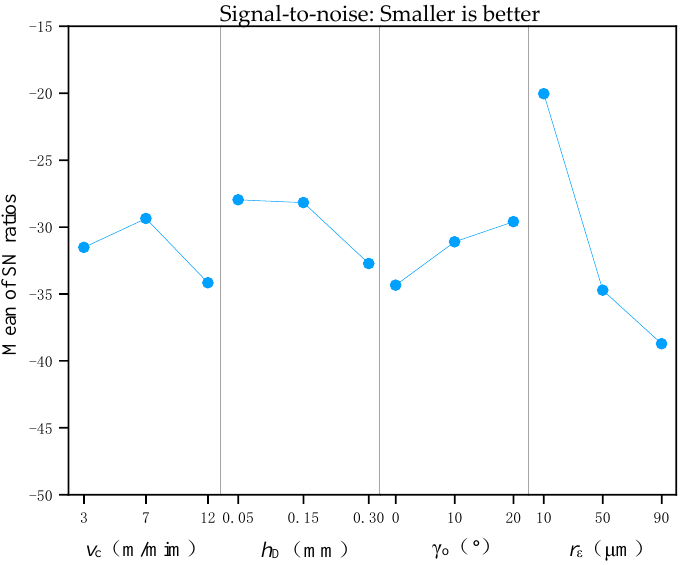
Figure 7. Signal-to-noise ratio of the cutting force in the vertical direction. Figures 6 and 7 present the optimal machining parameters for the graphite/polymer composite to obtain the minimum cutting force during orthogonal cutting.